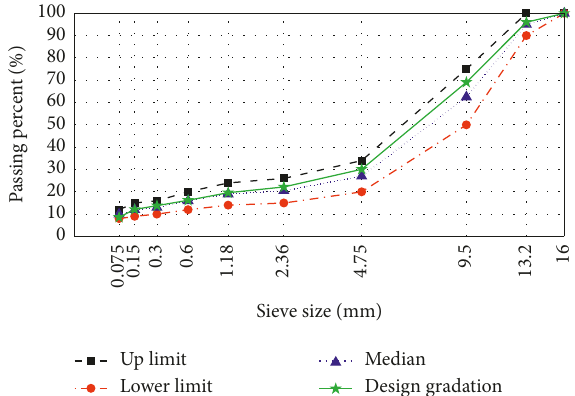
Figure 2: Grading design curve of SMA-13 asphalt mixture.